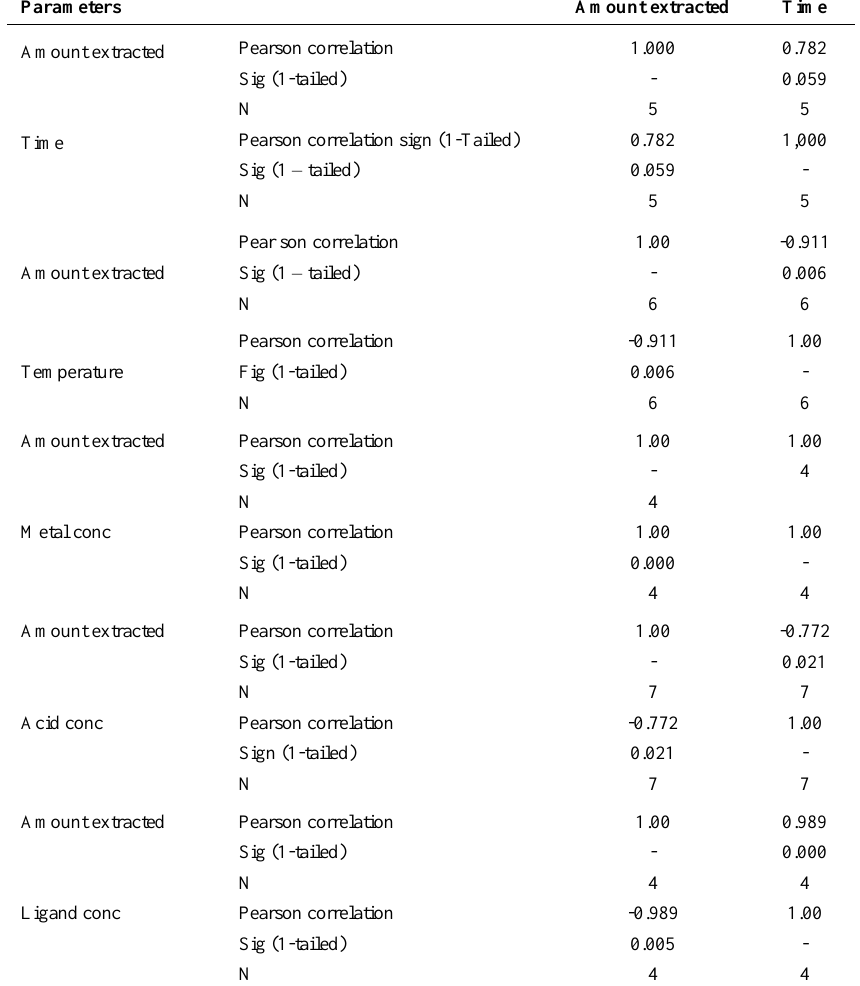
Table 4. Result of Pearson correlation for extraction of Mn(II)H 2 SAL complex